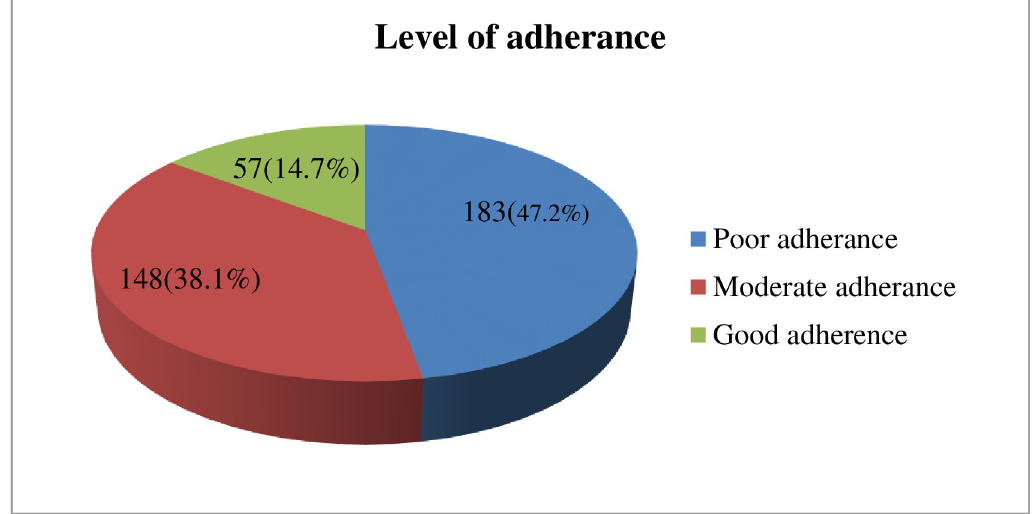
Fig 1. Overall adherences, level of COVID-19 preventive adherences among students of Jimma public high schools /2021 (N = 388).